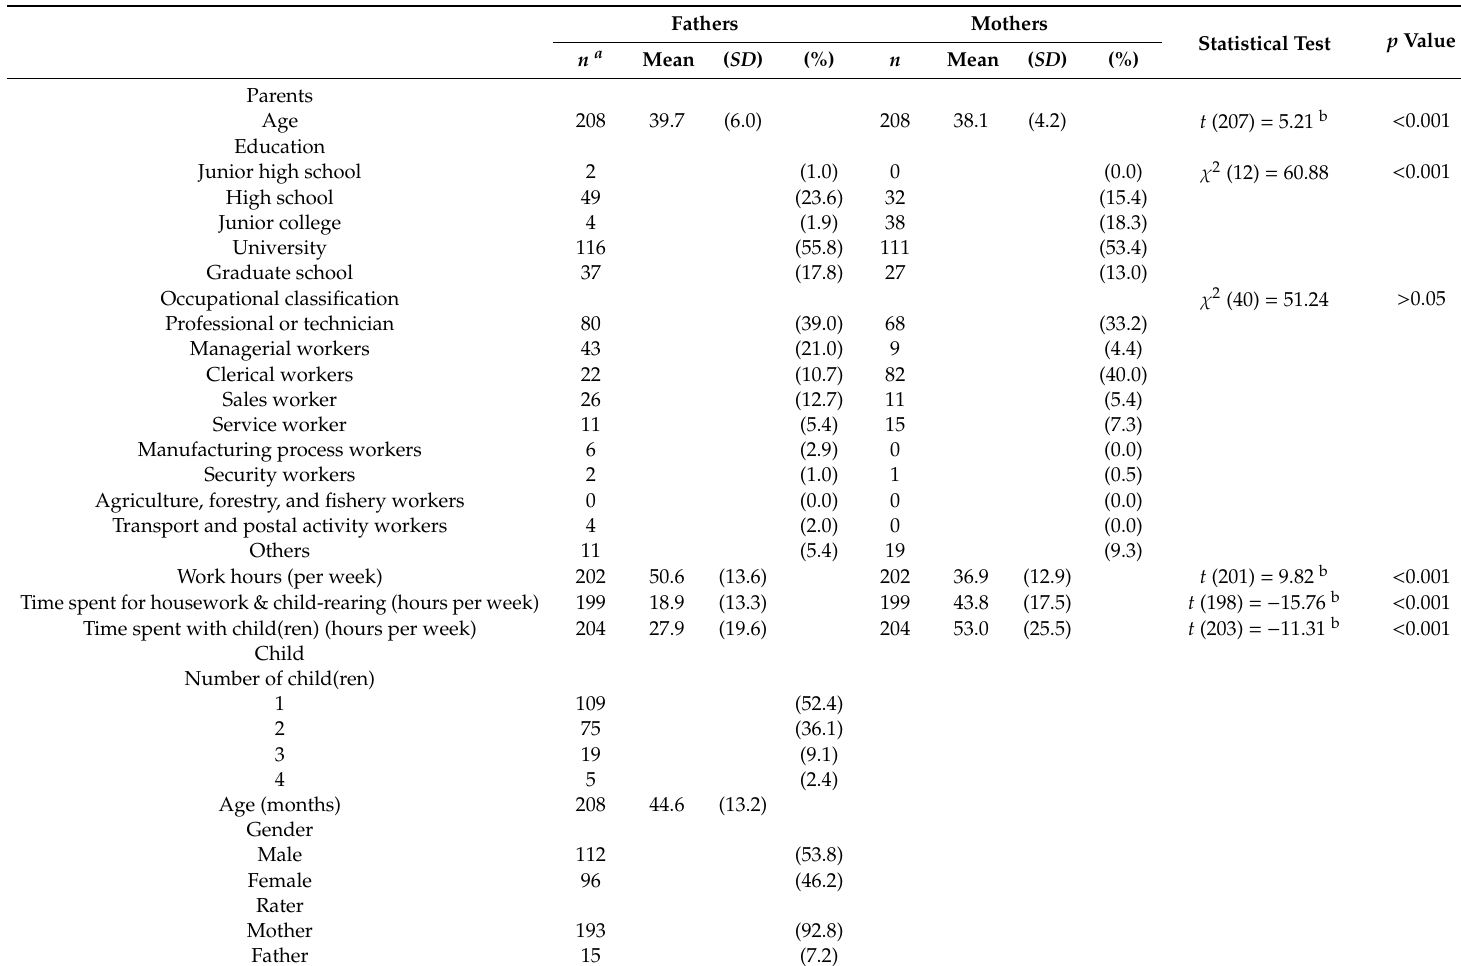
Table 1. Comparison of Means (and SDs) or numbers (and percentages) of demographic and variables between Fathers and